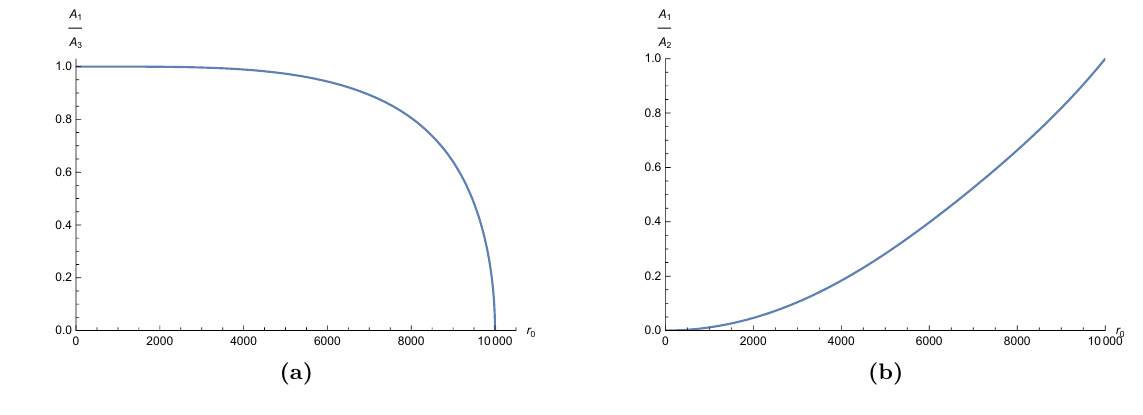
Figure 3. r UV = 10 4 , n = m = δ = β = 2